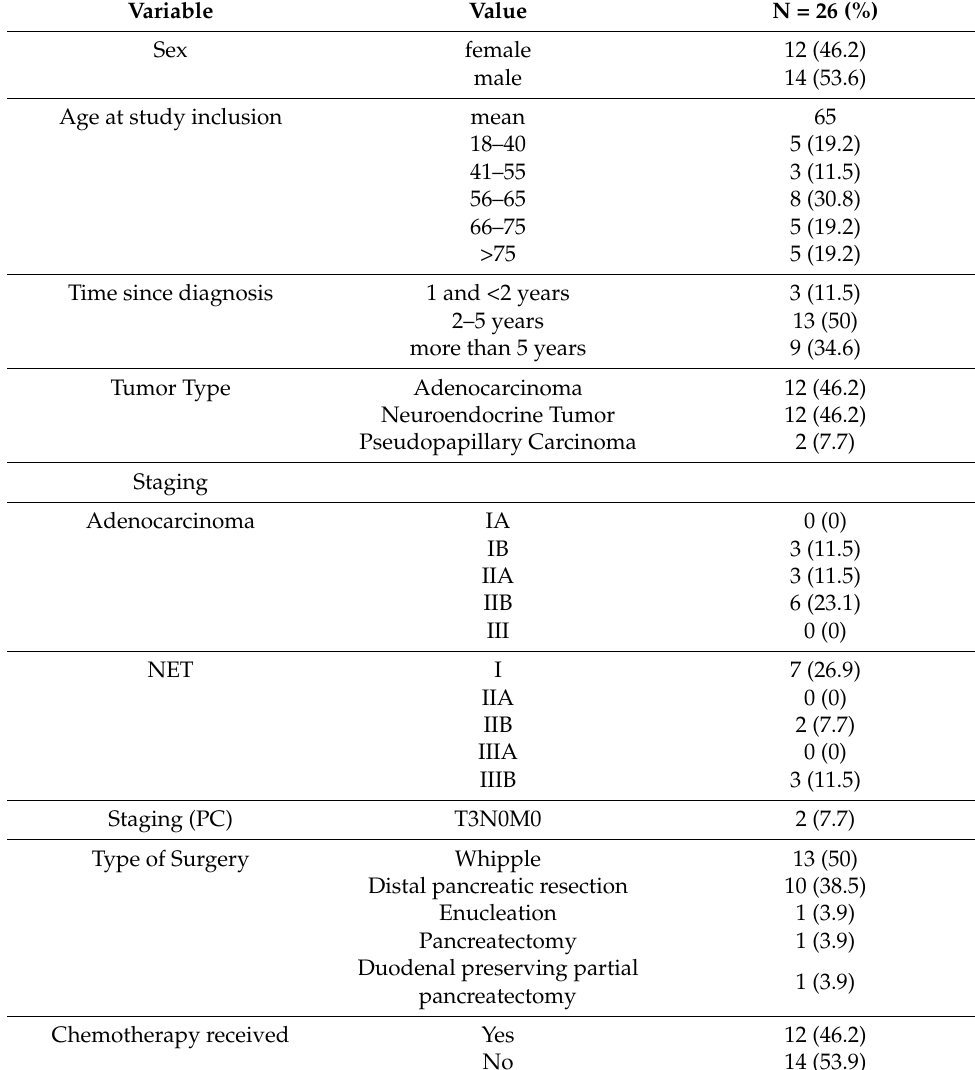
Table 1. Description of study